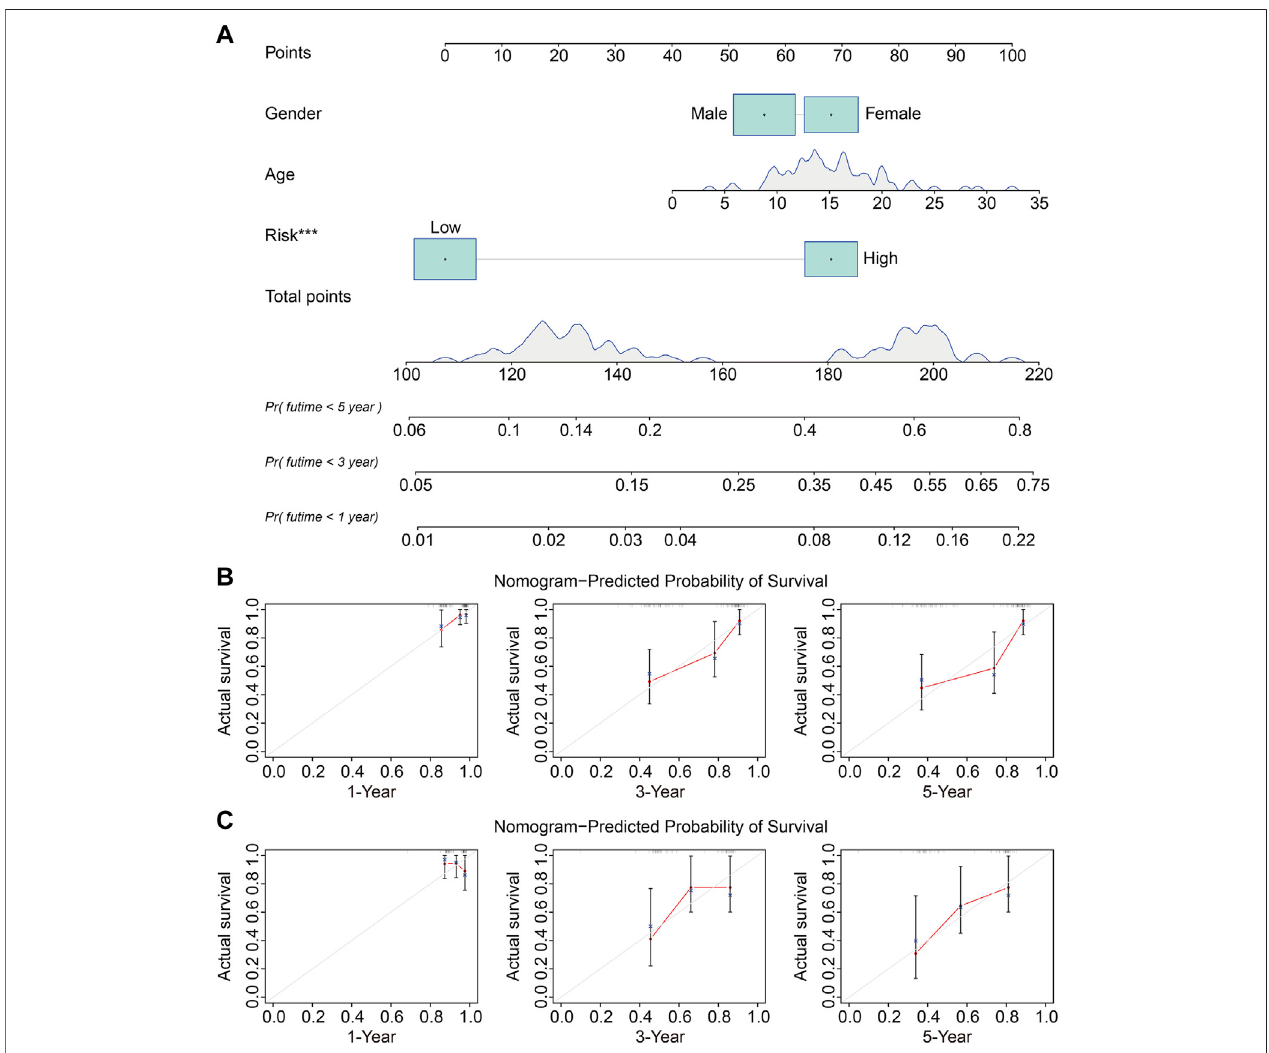
FIGURE6| ConstructionandvalidationofanomograminTCGAosteosarcomacohortandGSE21257cohort. (A) Theprognosticnomogramforpredicting1-,3-, 5-yearsoverallsurvivalofosteosarcomapatients. (B,C) Thecalibrationcurvesfor1-,3-,5-yearsoverallsurvivalpredictioninTCGAentirecohortandexternalGSE21257 cohort. In a well-calibrated model, the predictions should fall on or close to the 45-degree diagonal line.